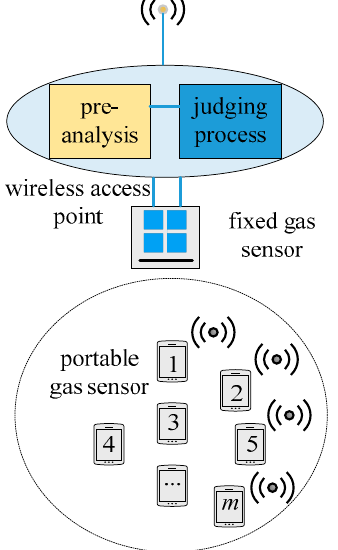
Figure 4. Scene of “multi ‐ point, single ‐ position”. Algorithm 1. Cluster ‐ based self ‐ adaptive weighted data fusion algorithm.